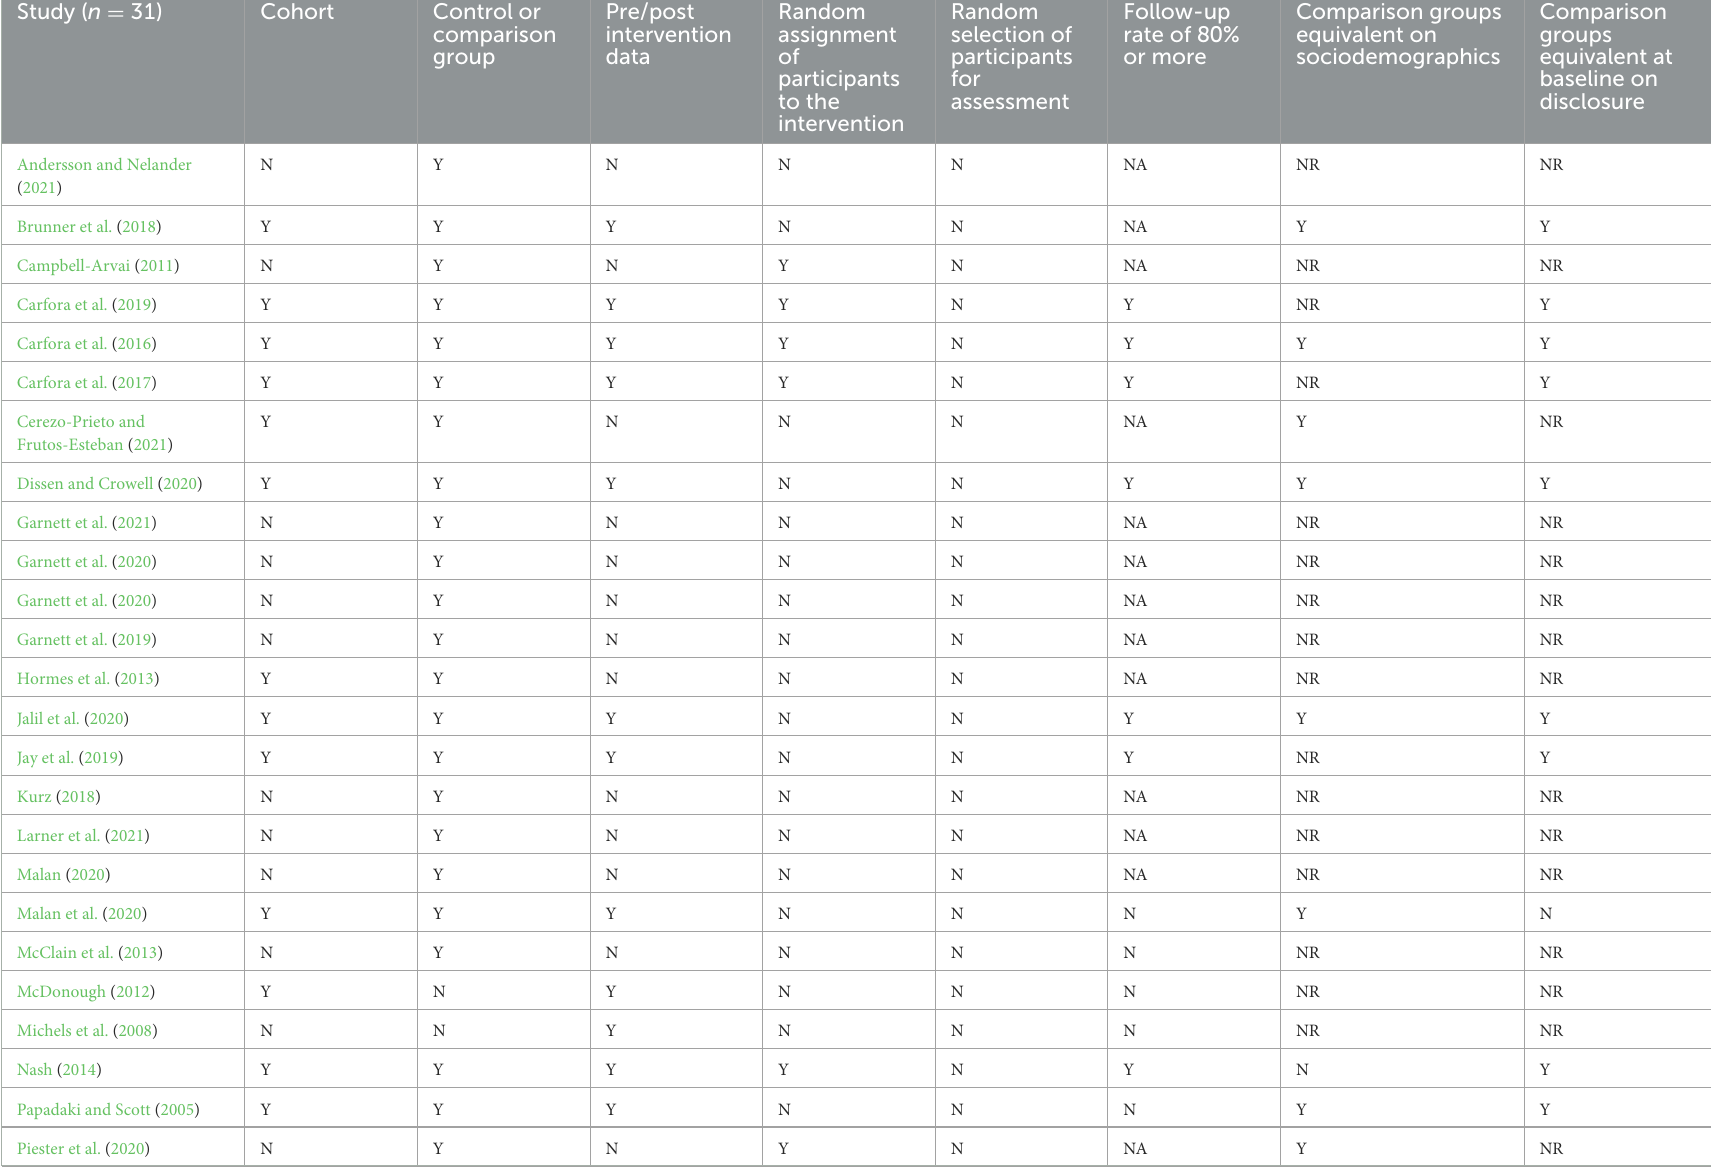
TABLE 2 Table summarizing the results of our quality assessment and risk of bias